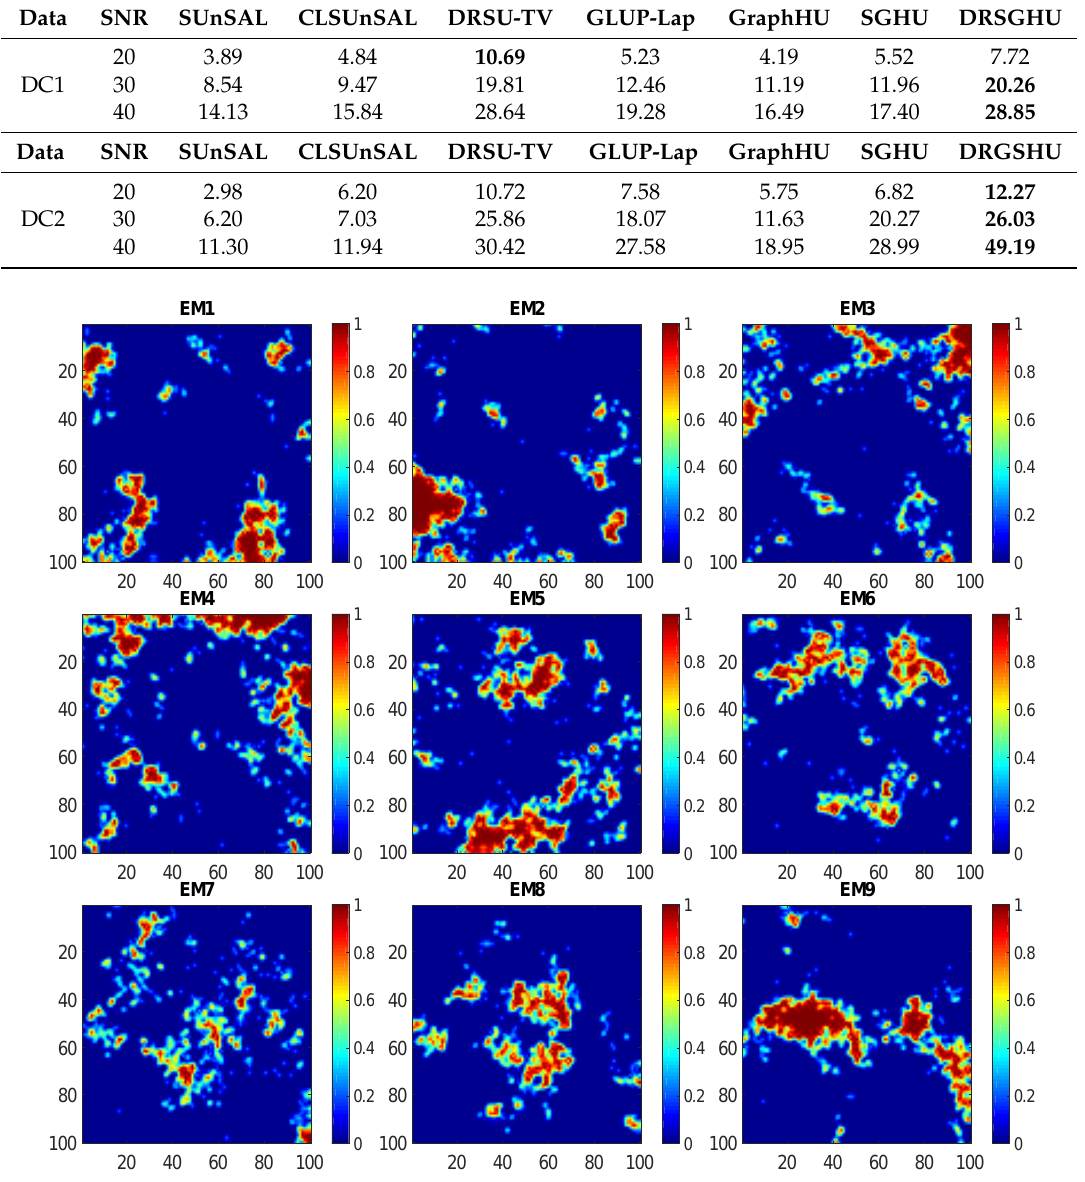
Figure 1. True fractional abundances of endmembers of